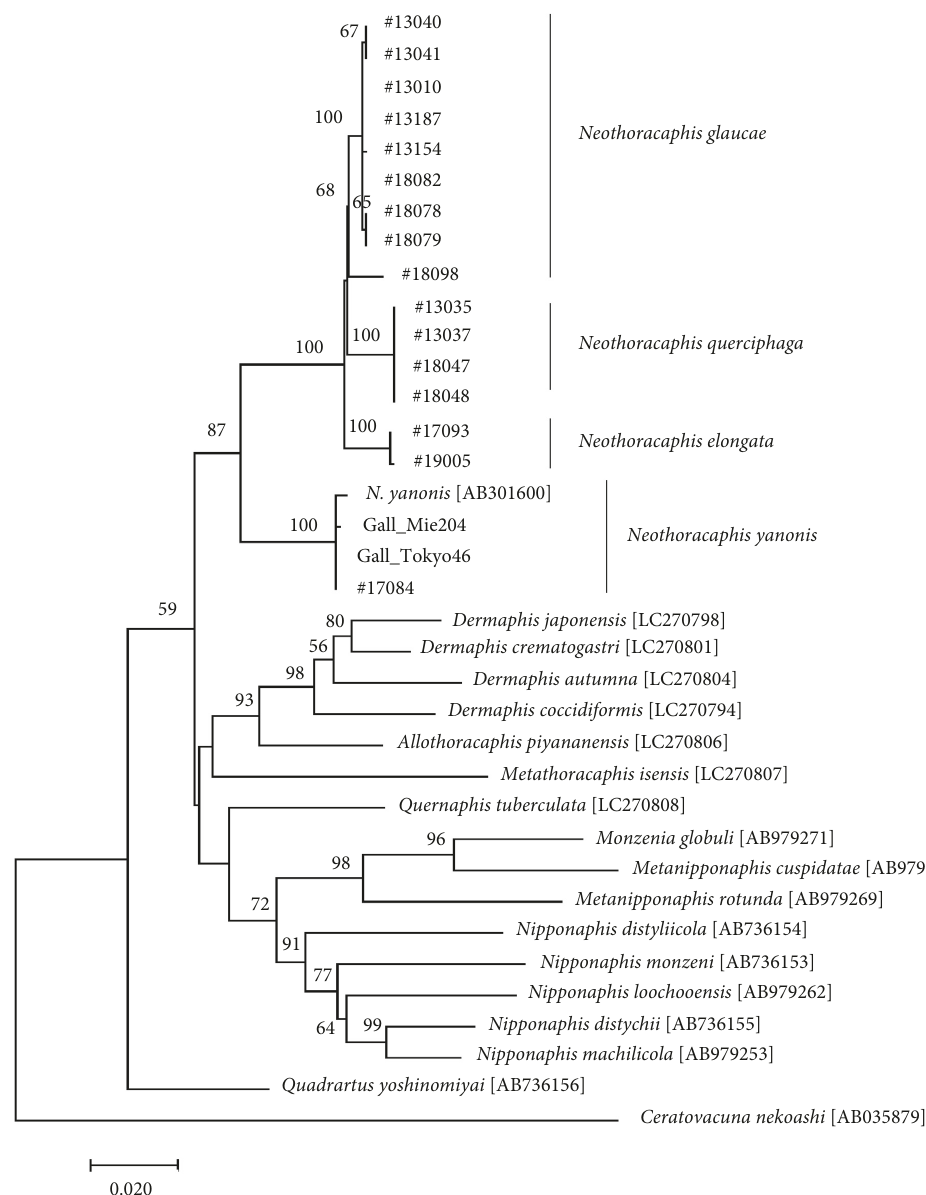
Figure 6: The maximum likelihood (ML) phylogeny of nipponaphidines including four Neothoracaphis species inferred from un- ambiguously aligned 1,520 nucleotide sites of their mitochondrial rRNA gene sequences. Bootstrap values higher than 50% are indicated on the